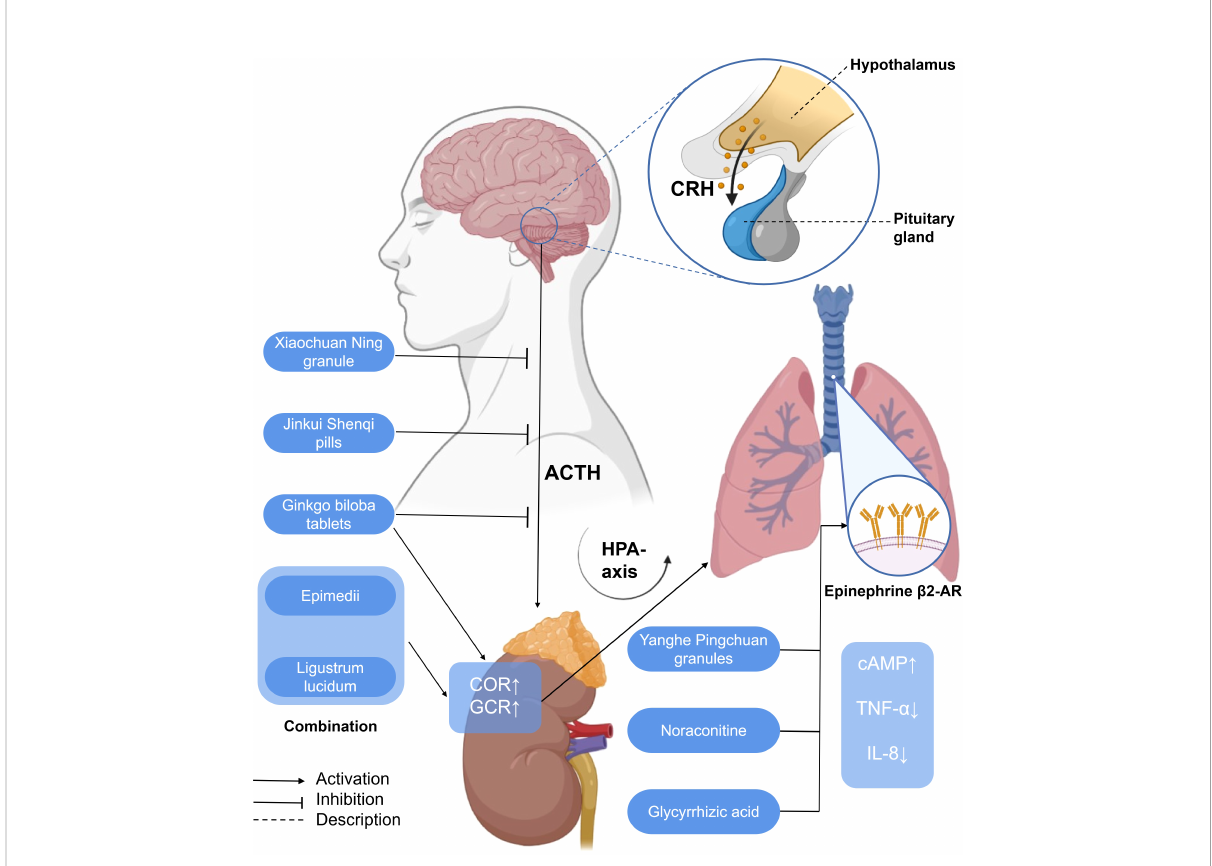
FIGURE 5 A simpli fi ed schematic diagram of the messenger role of some hormones in the treatment of asthma with traditional Chinese medicine. Yanghe Pingchuan granules, noraconitine, and glycyrrhizic acid induce airway smooth muscle dilation and relieve asthma by activating adrenaline b 2- AR. Activating G-protein-coupled cAMP signaling pathway (not shown) inhibits IL-8 secretion and asthma airway in fl ammation associated with NF- k B (not shown) induced by TNF- a . Ginkgo biloba tablets combined with Herba Epimedii and Ligustrum lucidum can promote the increase of COR, affect the HPA axis through the action of GCR, and alleviate airway in fl ammation. G. biloba tablets, Xiaochuan Ning granule, and Jinkui Shenqi pills can reduce the expression of ACTH, affect the HPA axis, and, fi nally, alleviate airway in fl ammation. HPA axis, hypothalamic – pituitary – adrenal axis; CRH, corticotropin-releasing hormone; ACTH, adreno-cortico-tropic-hormone; COR, cortisol; GCR, glucocorticoid receptor; cAMP, cyclic adenosine monophosphate; TNF- a , tumor necrosis factor- a ; IL-8,